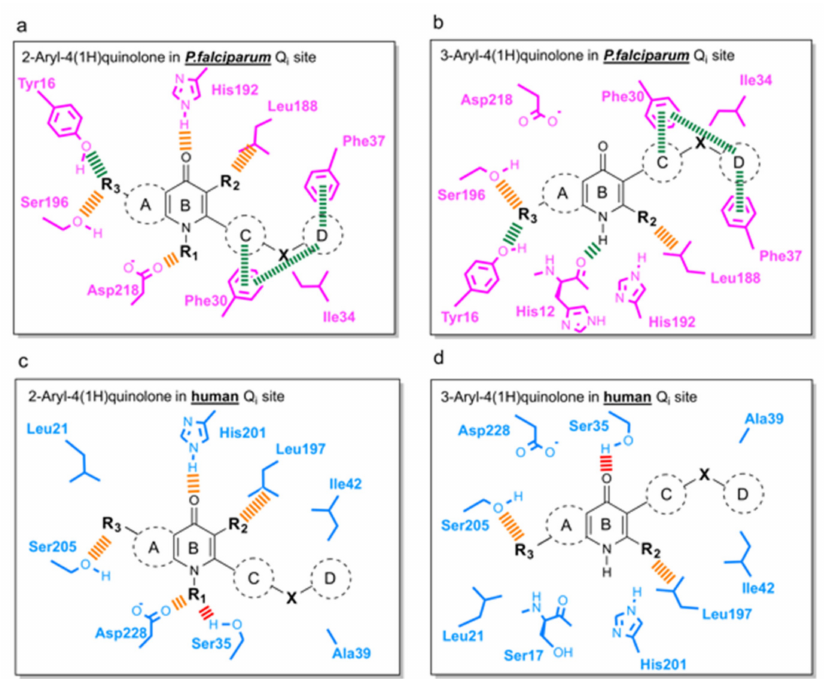
Figure 6. Schemes for the future development of aryl-4(1H)-quinolones targeting the Q i site binding. ( a ) 2-Aryl-4(1H)-quinolones in P. falciparum bc 1 . ( b ) 3-Aryl-4(1H)-quinolone in P. falciparum bc 1 . ( c ) 2- Aryl-4(1H)-quinolones in human bc 1 . ( d ) 3-Aryl-4(1H)-quinolone in human bc 1 (based on PDB: 5XTE). Colored dashed bars represent the interactions that could be considered for lead compound design: green—the interactions observed only in P. falciparum ; orange—the interactions observed in both species; red—the interactions observed only in